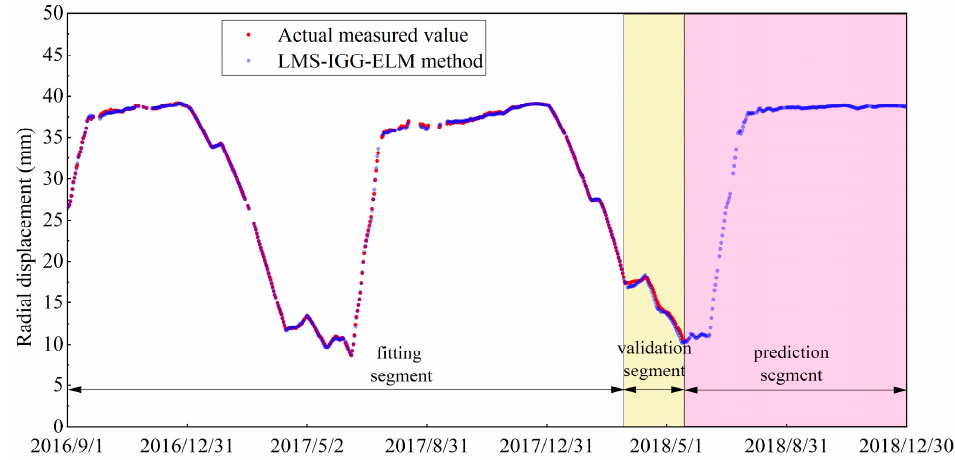
Figure 7. Dam monitoring model after eliminating gross errors by the LMS-IGG-ELM method.